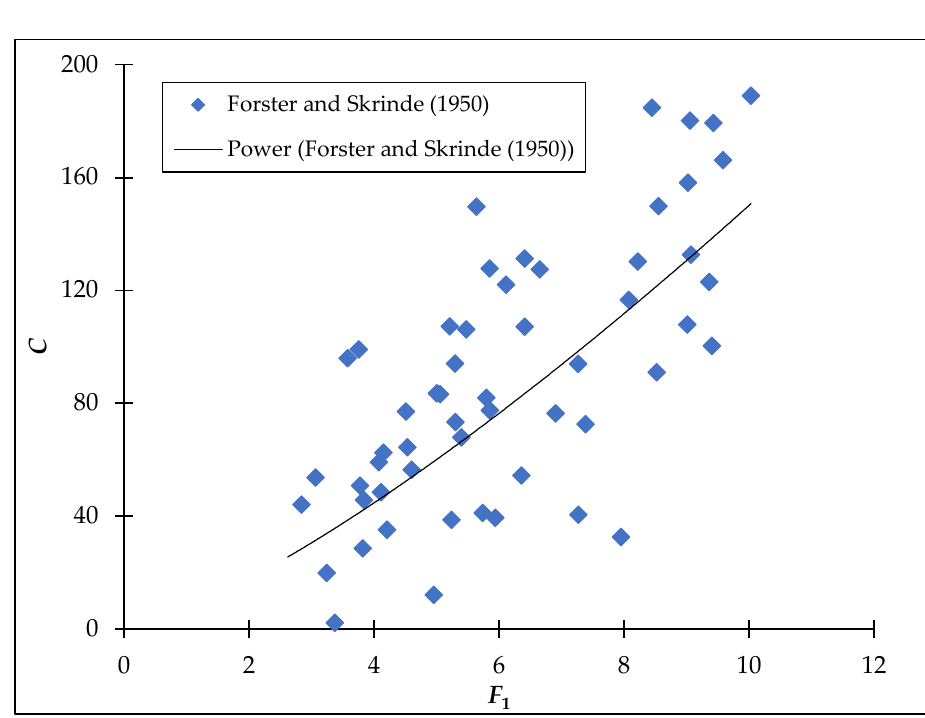
Figure 5. Curvature correction coefficient variation with initial Froude number.